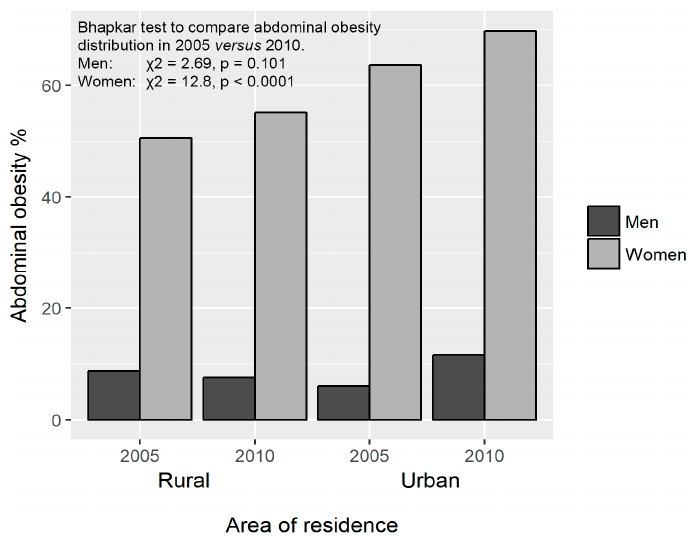
Figure 3. Abdominal obesity prevalence stratified by sex and residence at the two time points.